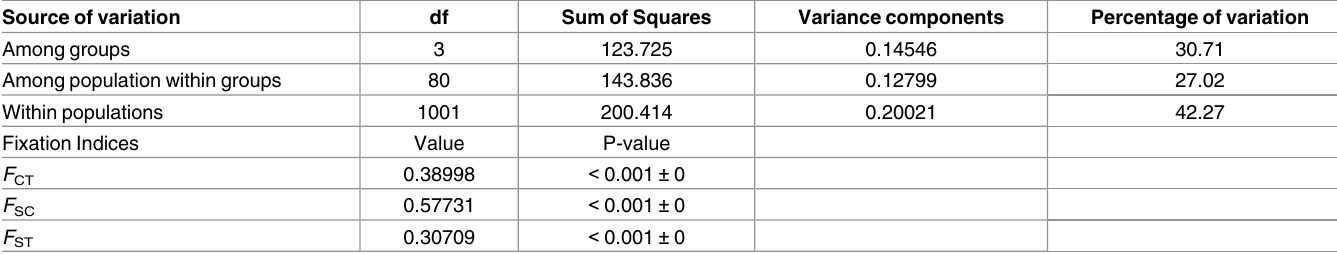
Table 1. Structure of populations within Clade A as determined by